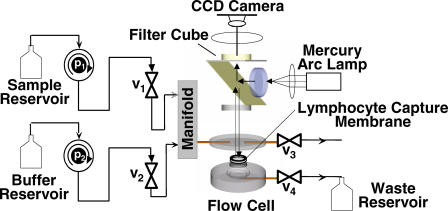
Components of the ETC SystemA fluid delivery system is used to introduce sample containing fluorescently stained lymphocytes in whole blood and wash buffer to a capture flow cell. Lymphocytes captured within the flow cell are visualized with a fluorescence imaging station using a mercury pressure lamp as a light source, and a CCD for image collection. Raw data images are then processed and analyzed using an automated algorithm run by an attached computer. The flow cell includes a polymer membrane supported on a chip and two transparent polymethylmethacrylate inserts that allow for the optical evaluation of captured lymphocytes.